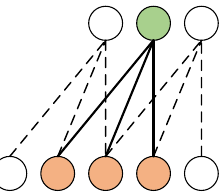
Figure 6. Causal convolution. Kernel size = 3.